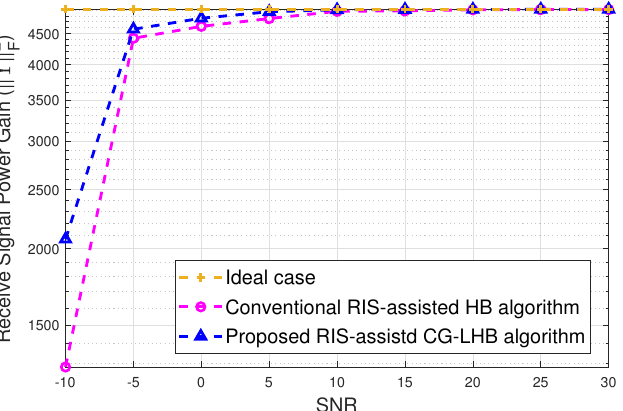
Figure 3. Received power gain versus SNR with the proposed CG−LHB algorithm.